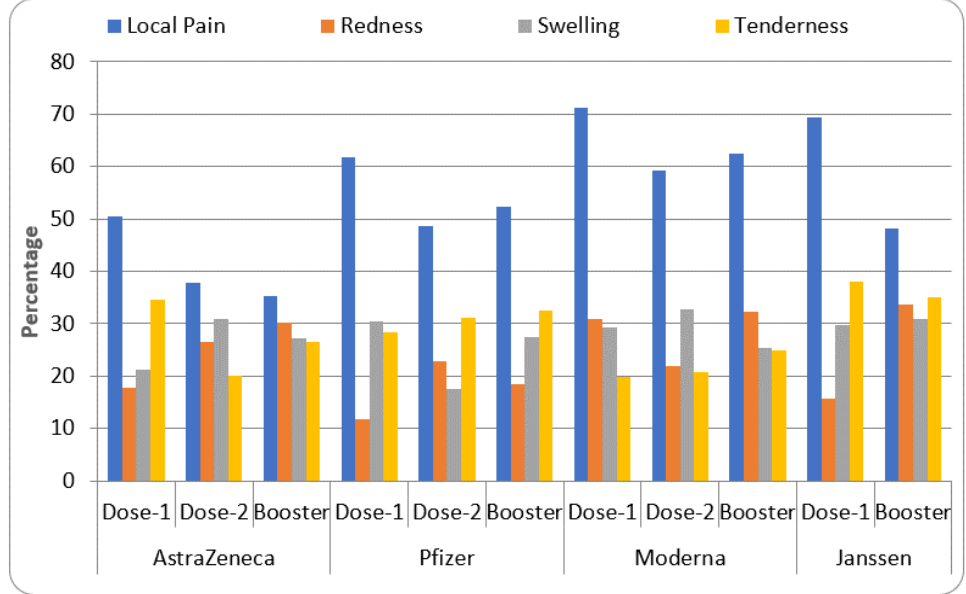
Figure 3. Common local reactions after COVID-19